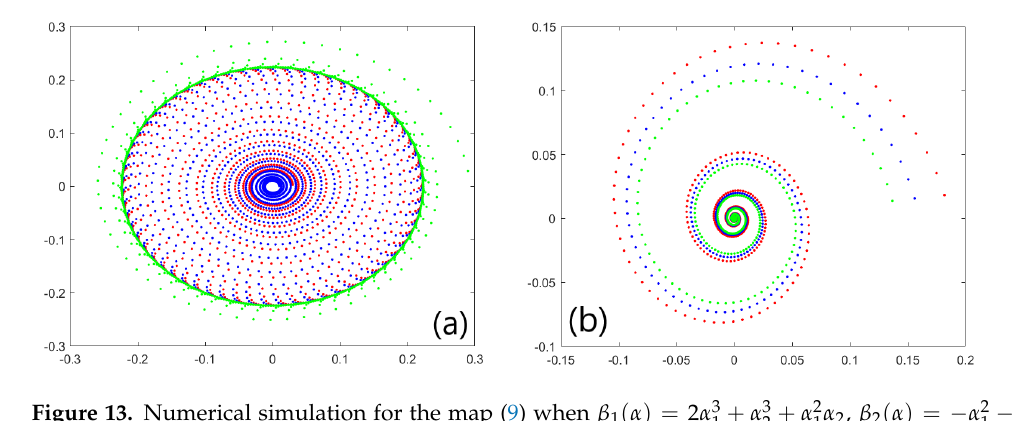
+ α 3 + α 2 − α 2 , β 2 ( α ) = − α 2 2 1 1 1 = 0.1, α = 0.1; ( b ) the three orbits are represented here 2 1